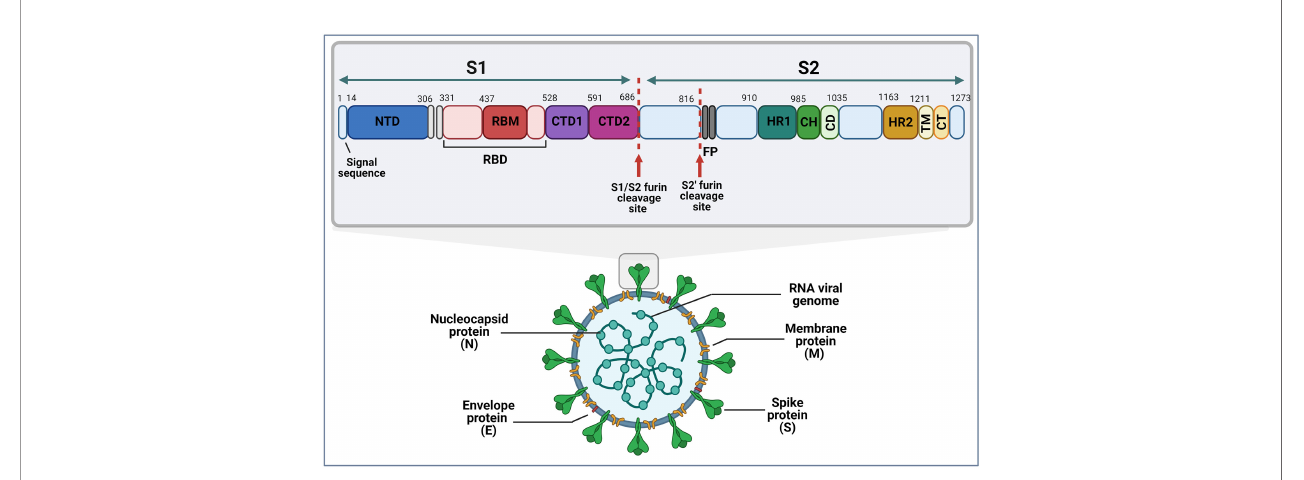
FIGURE 2 | Schematic representation of the SARS-CoV-2 virion and the domain structure of its spike protein. Furin cleavage sites are as indicated, and numbers represent amino acid positions within the protein. (S1&S2, subunit 1 & 2; NTD, N-terminal domain; RBM, receptor binding motif; RBD, receptor binding domain;